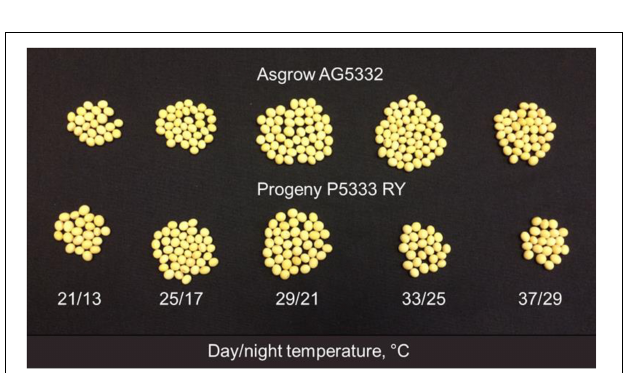
FIGURE 4 | Temperature effects on a soybean seed number and size of AG and PR. The photograph represent 10% of the seed number per plant in each treatment. For total number of seed per plant, refer to Figure 3C .